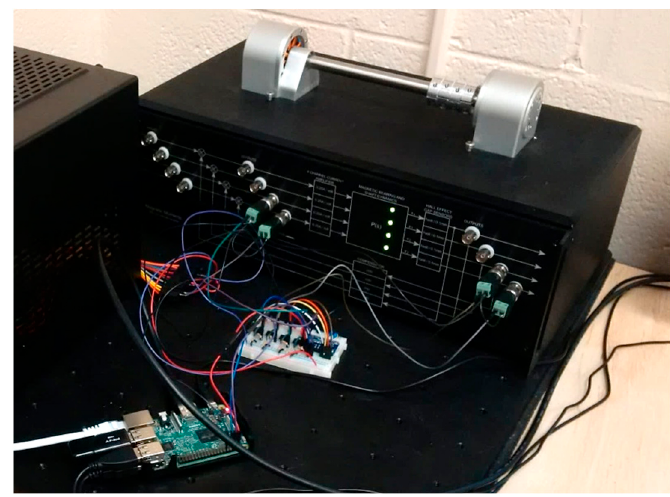
Figure 3. Experimental AMB test rig with attached Raspberry Pi single board computer, ADC, and conditioning circuitry.